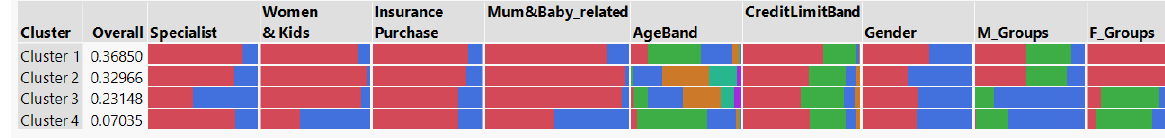
Figure 12. Customer cluster characteristics summary from four-cluster LCA model.